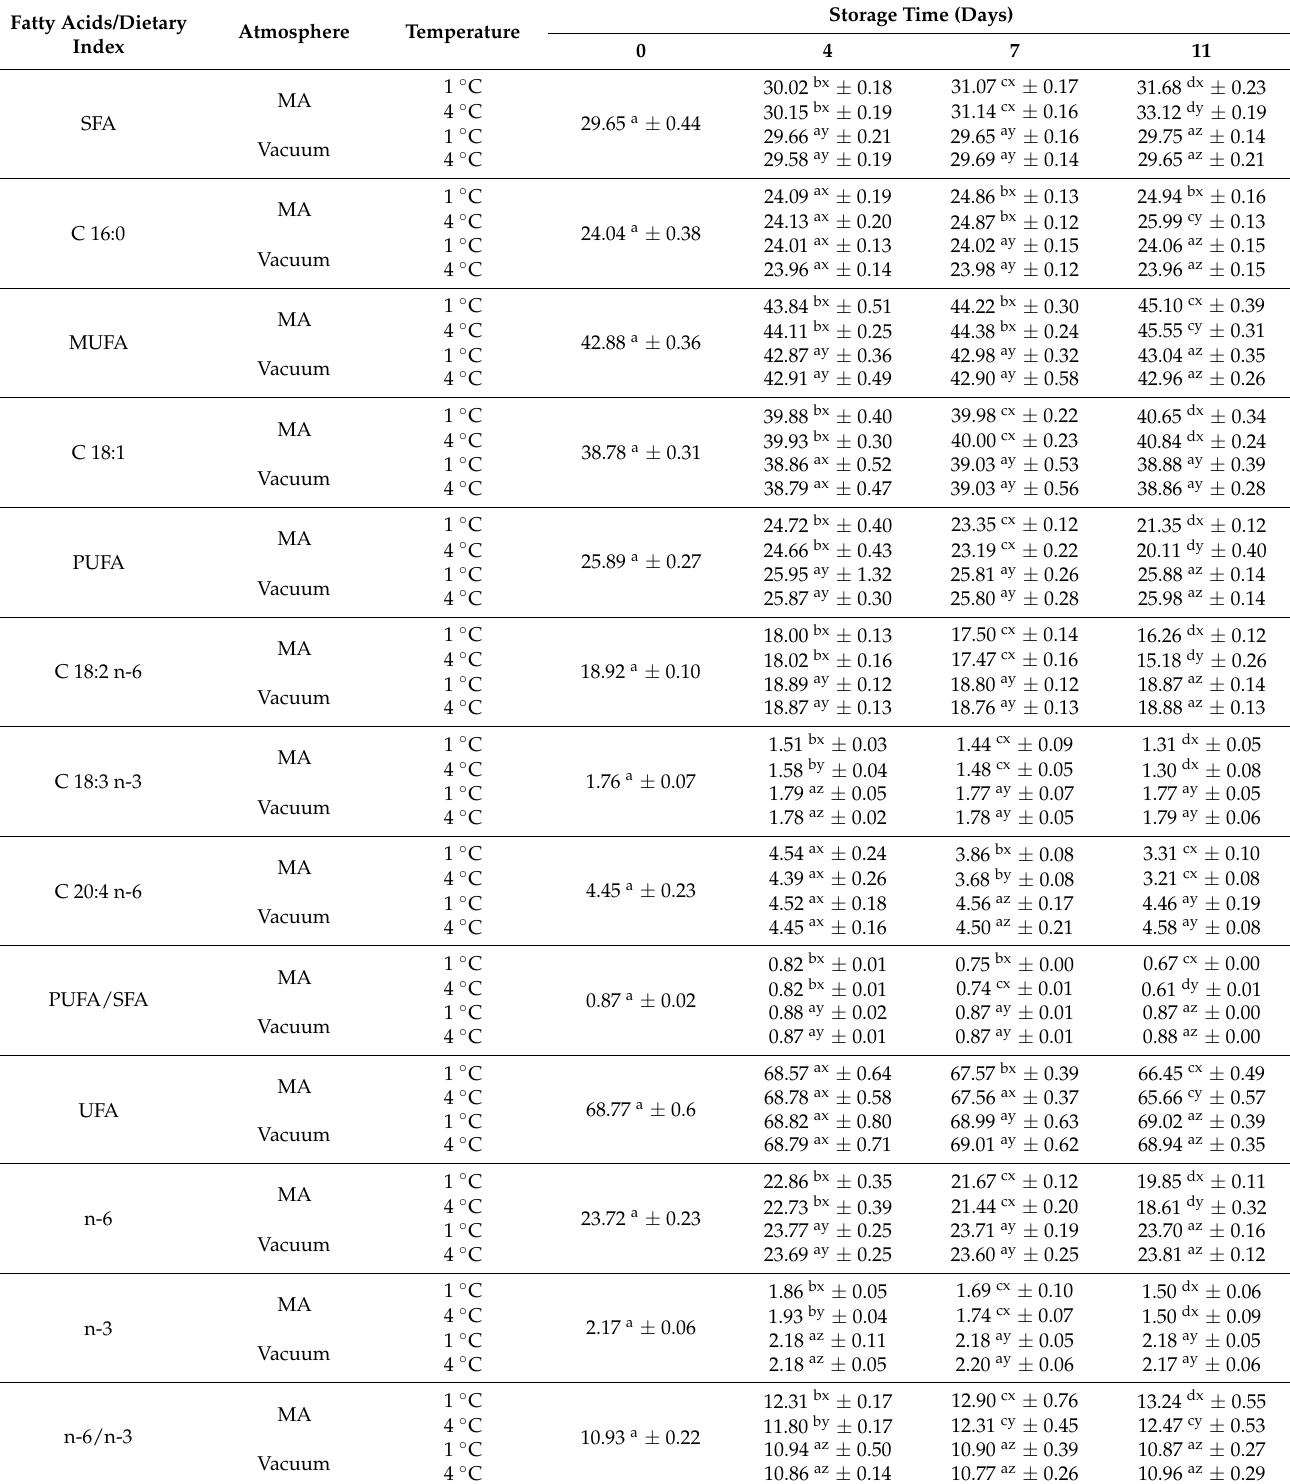
The profile, proportions, and indices of fatty acids of the goose breast muscles packed in the protective atmospheres and stored at 1 ◦ C and 4 ◦ C for 11 days are presented in Table 3. Table 3. The significance of the differences for mean values of fatty acid profile (% of the total fatty acids) and dietary indexes of goose meat stored in different atmospheres at 1 ◦ C and 4 ◦ C for up to 11 days in the post hoc Tukey’s test ( p <